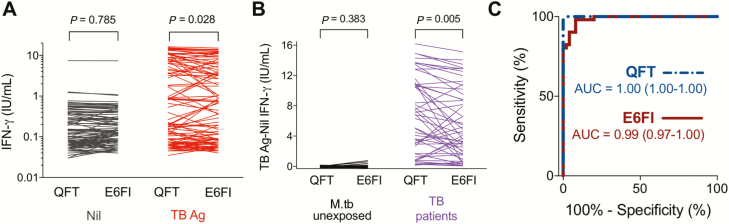
ESAT-6–free IGRA diagnostic accuracy in M.tb-unexposed controls and TB patients. Blood was collected from M.tb-unexposed controls (n = 50, cohort 2a) and microbiologically confirmed TB patients (n = 51, cohort 2b) in QFT and ESAT-6 free IGRA (E6FI) tubes and stimulated for 16–20 hours at 37°C; the IFN-γ concentration was measured by QFT enzyme-linked immunosorbent assay. A, Paired analysis (Wilcoxon matched-pairs signed rank test) of IFN-γ values measured upon blood stimulation in QFT and E6FI Nil or TB Ag tubes in all participants. B, Paired analysis (Wilcoxon matched-pairs signed rank test) of IFN-γ values measured by QFT and E6FI (TB Ag – Nil) in M.tb-unexposed controls and TB patients. C, Receiver operating characteristic analysis of diagnostic accuracy of QFT (dashed line) and E6FI (solid line) assays. Area under the curve and 95% confidence interval are shown. Abbreviations: Ag, antigen; ESAT-6, early secretory antigenic target-6; IFN-γ, interferon-gamma; IGRA, interferon-gamma release assay; M.tb, Mycobacterium tuberculosis; QFT, QuantiFERON-TB Gold In-tube; TB, tuberculosis.